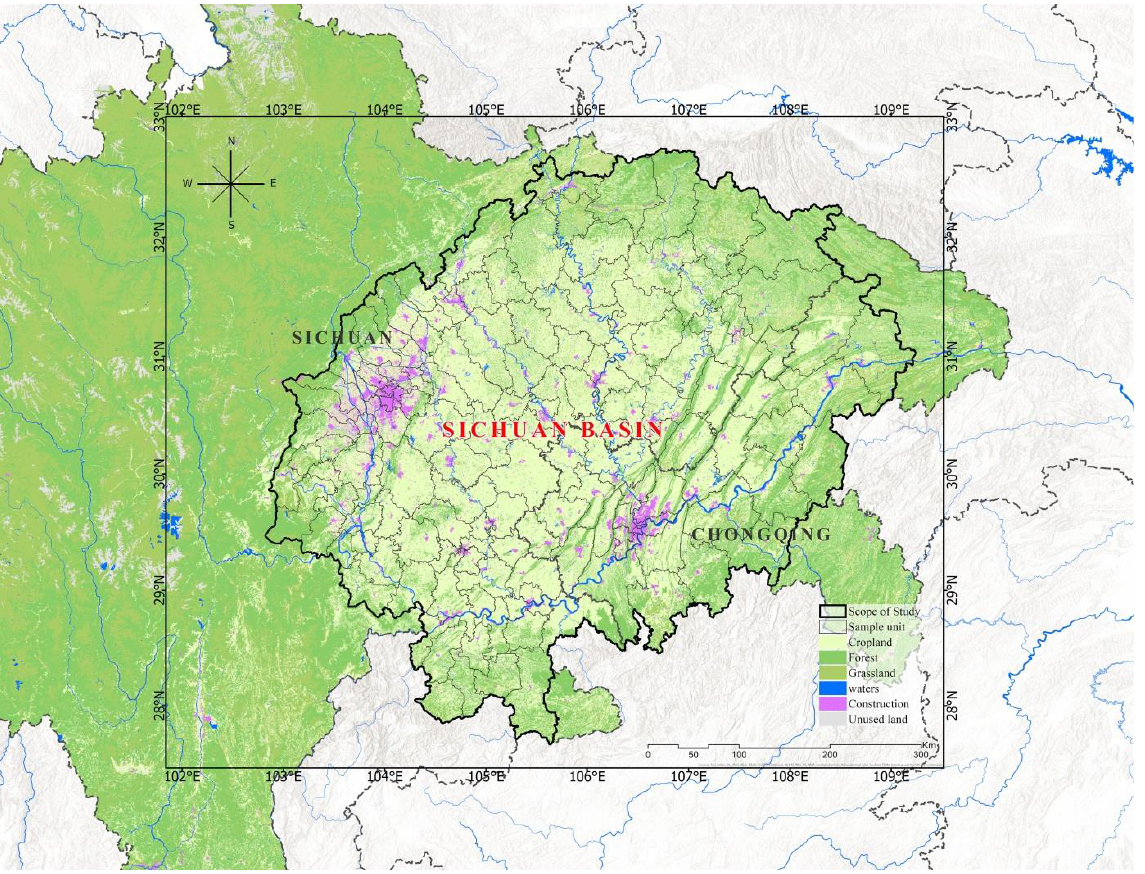
Figure 1. The study area of Sichuan Basin: Land use in 2015.